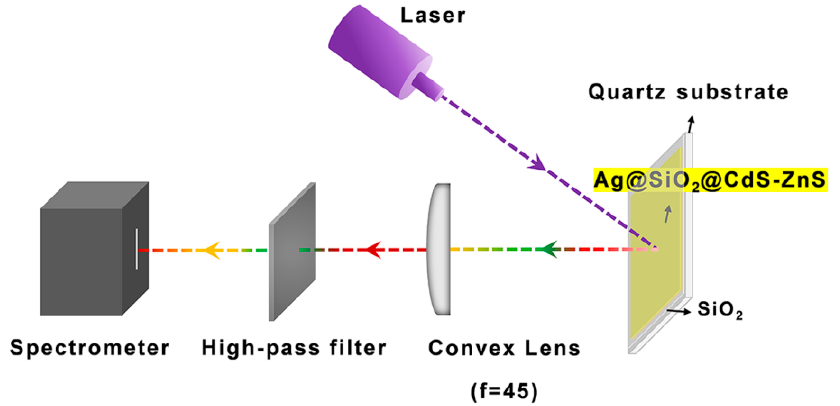
Figure 1. Fluorescence temperature sensor system based on a Ag@SiO 2 @CdS/ZnS composite nanoparticle film.